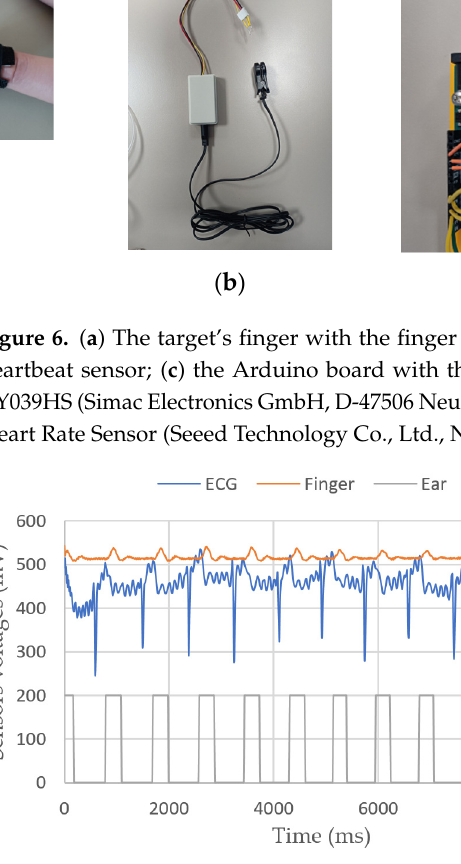
Figure 9. ECG, finger and ear heartbeat sensors’ voltages vs. time. In this third measurement, the target is standing and bending their knees multiple times between 5 and 10s. 3.1.3 Circuit Diagrams We show the overall structure for the circuits of the measurement platform in Figure 10.